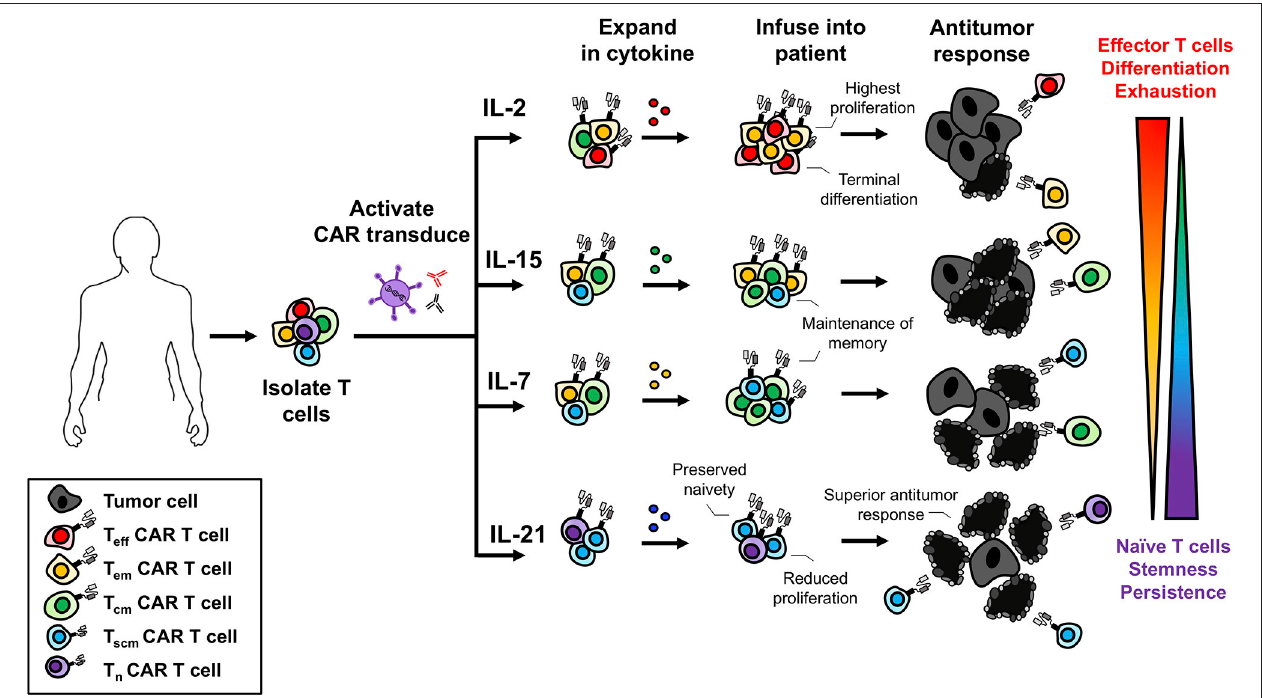
FIGURE 2 | Use of γ c cytokines for ex vivo T cell expansion generates T cells with variable memory phenotypes. γ c cytokines promote different biological programs that influence the differentiation of T cells. While IL-2 promotes robust proliferation it also promotes terminal effector differentiation. IL-7 and IL-15 maintain the homeostasis and survival of memory T cells and treatment ex vivo promotes a Tscm/Tcm phenotype. IL-21 slows T cell expansion but prevents differentiation and maintains a naïve-like T cell phenotype. With respect to antitumor immunity, less differentiated cell products are more therapeutic leading to the understanding that IL-2 is not the best option for ex vivo